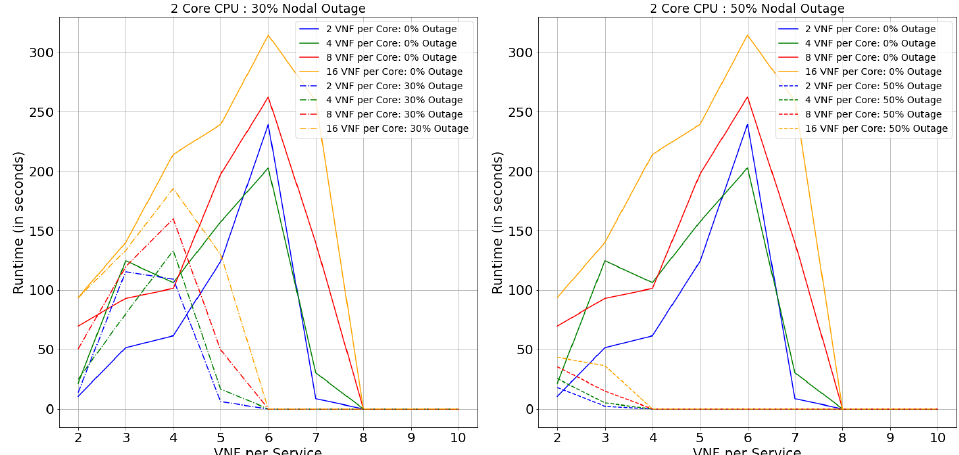
Figure 21. Runtime: Netrail topology with nodal outage—2 core CPU.